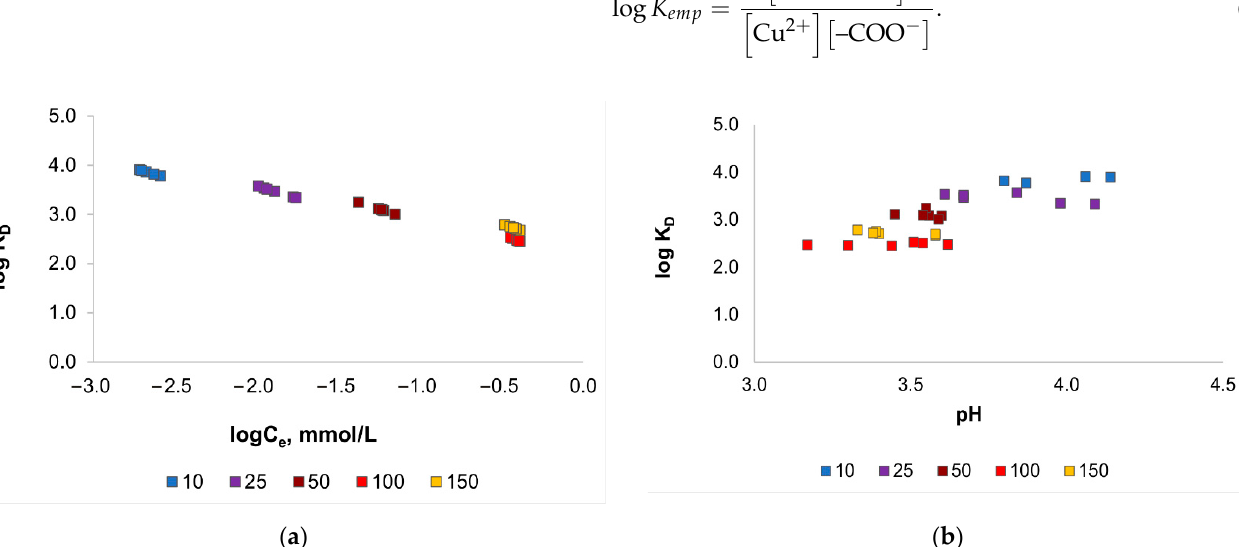
Figure 6. Distribution ratio K D vs equilibrium copper concentration in solution ( a ) and pH ( b ). Squares of different colors indicate the initial copper concentration.